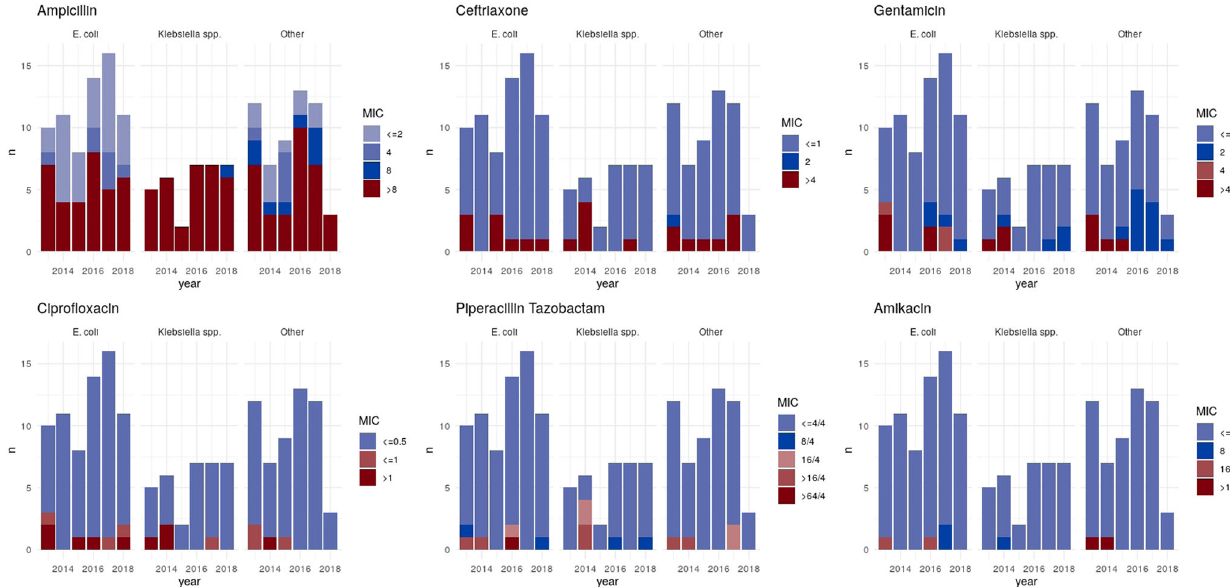
Fig. 1 Change in minimum inhibitory concentrations (MIC) of isolates over time. MIC is shown for each drug in